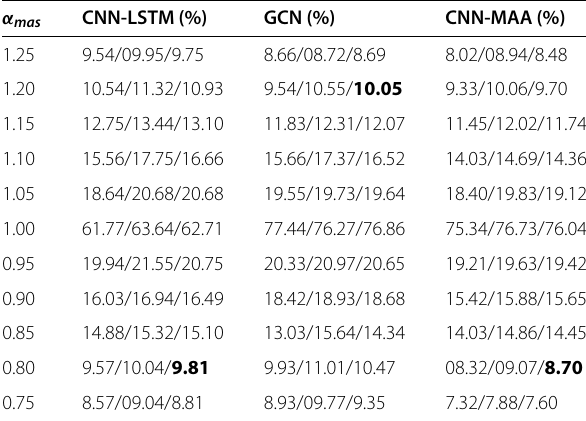
of frequency bins and frames, respectively. A temporal sequence of the log amplitude spectrogram at frequency f , [ log | X ( f ,1 ) | , ..., log | X ( f ,1 ) | ], is filtered by a zero-phase